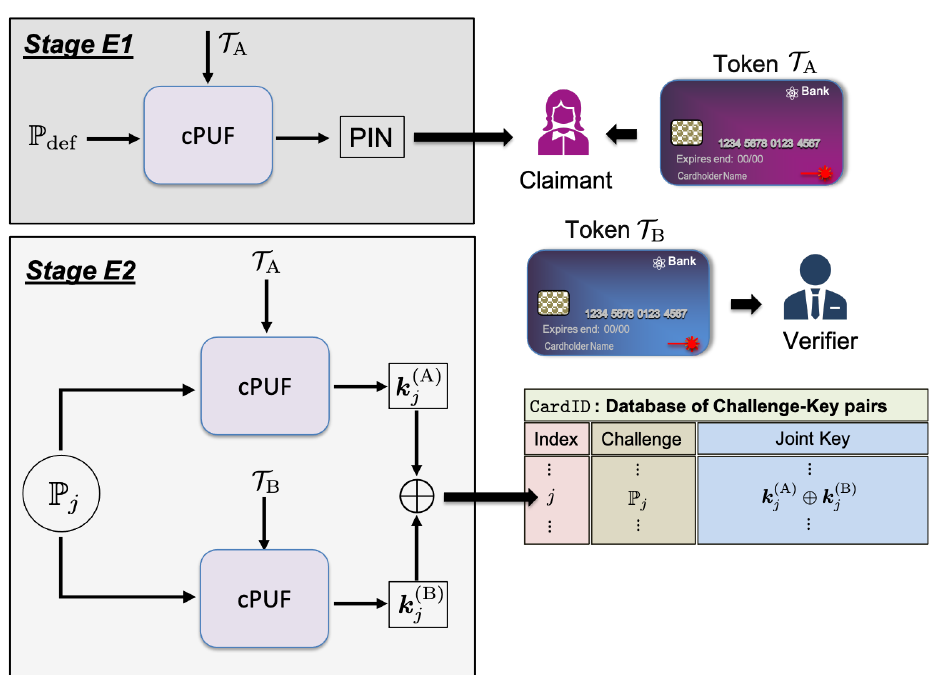
Figure 3. Schematic representation of the two stages in the enrollment of a token to the system, for the protocol discussed in Section 3. The procedure takes place only once by the manufacturer, in a secure environment. Stage E1 aims at the generation of a PIN which is correlated with the token. Stage E2 aims at the generation of a database of challenge-response pairs for the particular token. The PIN and the token T A are given to the legitimate user, whereas the parameters of the light P def used in stage E1 are publicly